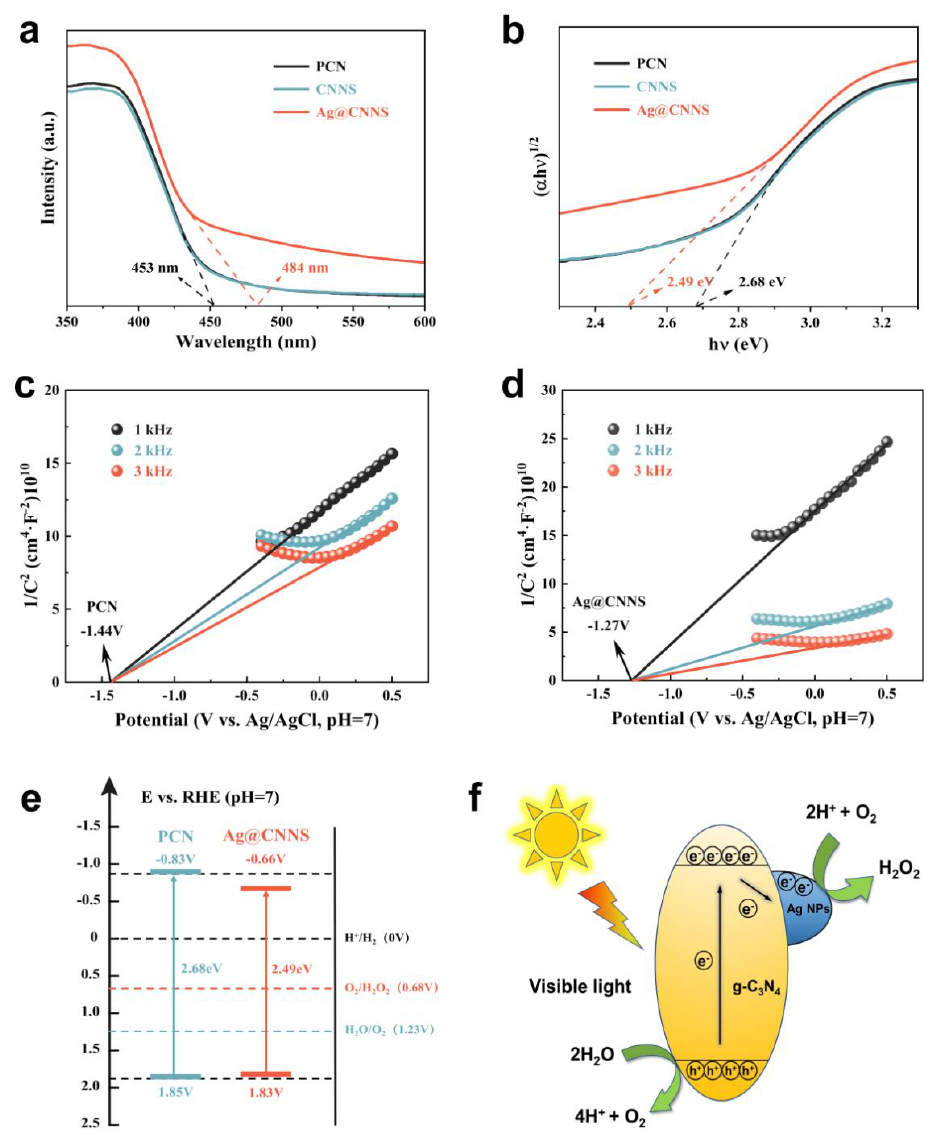
Figure 2. ( a ) UV − vis DRS and ( b ) plots of transformed Kubelka − Munk function versus photon energy of PCN, CNNS, and Ag@CNNS; Mott − Schottky plots of ( c ) PCN, and ( d ) AgCNNS; ( e ) the schematic diagram of the band structure of PCN and Ag@CNNS; ( f ) schematic illustration of the enhanced photocatalytic mechanism of Ag@CNNS under visible − light irradiation.